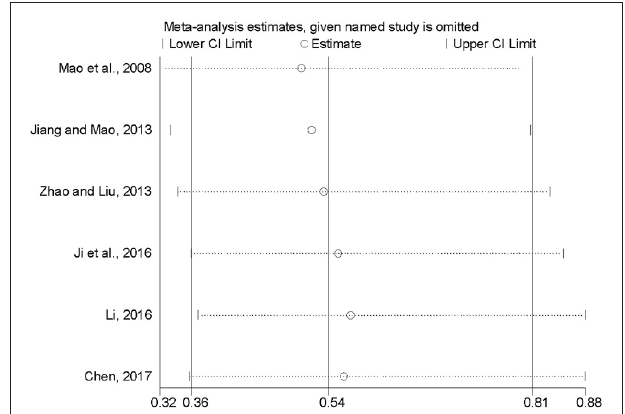
FIGURE 9 | Sensitivity analysis of 28-days